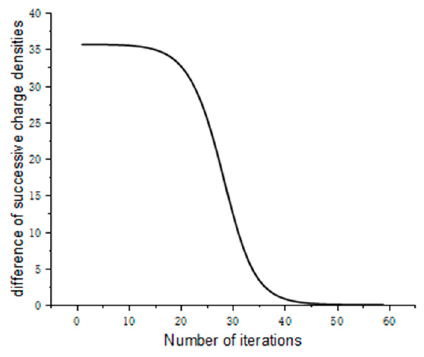
Figure 6. Convergence to terminal criteria.